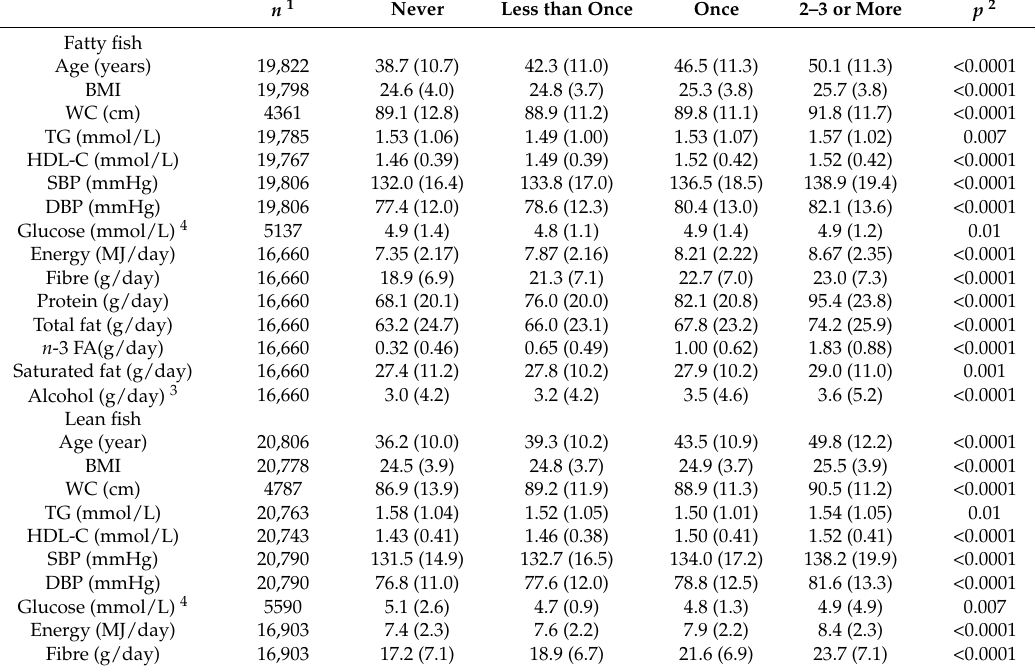
Table 3. Baseline characteristics (1994/1995) for continuous variables by frequency of weekly fish consumption mean (SD). n